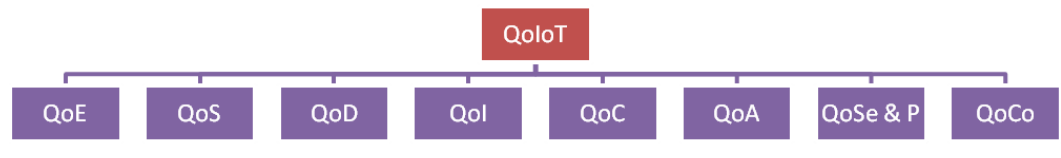
Figure 7. Quality IFs in the IoT